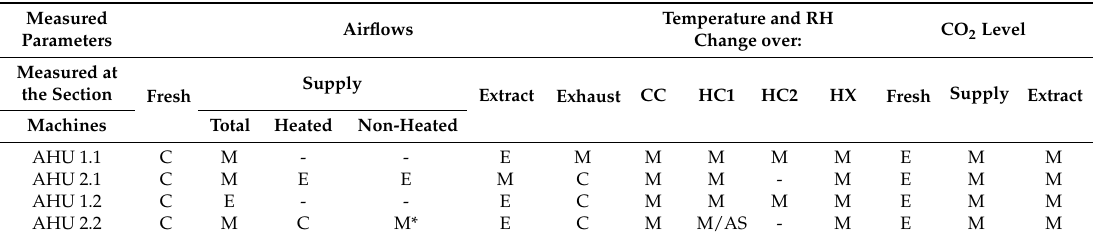
Table 1. Overview of the conducted measurements. M = measured, M* = measured short-term, AS = measured by the automation system, E = estimated, C = calculated, - = not valid for said AHU. Temperature and RH Measured CO 2 Level Airflows Change over: Parameters Measured at Supply the Section Fresh Extract Exhaust CC HC1 HC2 HX Fresh Supply Extract Machines Total Heated Non-Heated AHU 1.1 C